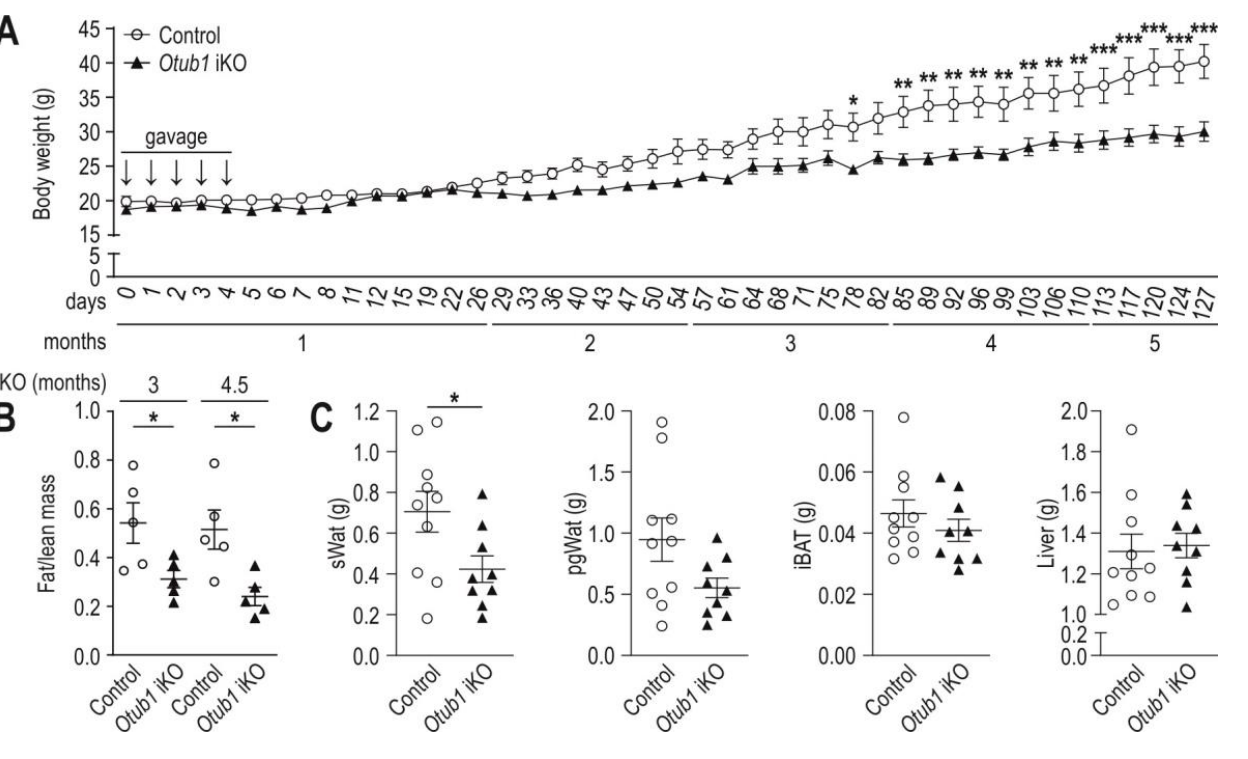
Figure 1. Body weight gain, fat and liver mass in mice with induced whole-body Otub1 KO. ( A ) Body weight (BW) development following vehicle application (control) or the induction of Otub1 KO in the whole body by tamoxifen treatment ( Otub1 iKO) in mice during months 1–5 ( n = 5). Vehicle or tamoxifen treatment by gavage was indicated by arrows. ( B ) Fat mass to lean mass ratio analyzed by EchoMRI in the mice shown in ( A ) at the indicated time after Otub1 KO (4.5 and 6 months of age; n = 5). ( C ) Weight of indicated organs (6 months after Otub1 KO; 8.5-month-old mice; 2.5-month-old mice were gavaged with tamoxifen; control, n = 10; Otub1 iKO, n = 9). sWAT, subcutaneous WAT; pgWAT, perigonadal WAT; iBAT, interscapular brown AT. All data are presented as the mean ± SEM. *, p < 0.05; **, p < 0.01; ***, p < 0.001 by two-way ANOVA with Bonferroni post-test ( A ) or two-tailed Student’s t -test ( B , C